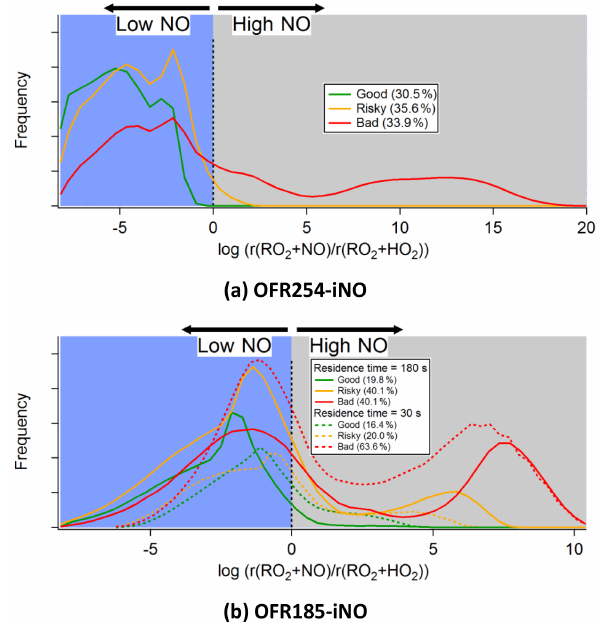
Figure 3. Frequency occurrence distributions of good, risky, and bad conditions (see Table 3) over logarithm of the ratio between RO 2 reacted with NO and with HO 2 (see Sect. S1 for more detail) for (a) OFR254-iNO (only the case with a residence time of 180s) and (b) OFR185-iNO (including two cases with residence times of 180 and 30s). Low- and high-NO regions (see Table 3) are colored in light blue and gray,